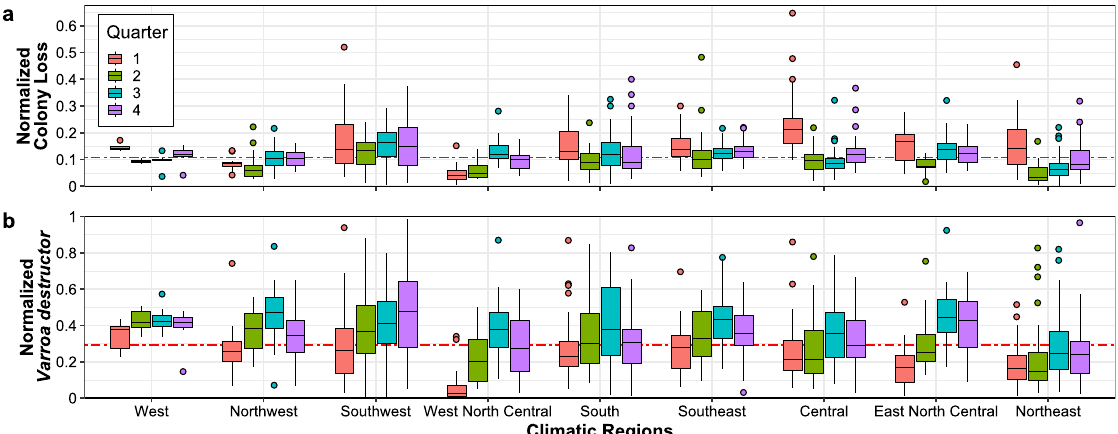
Figure 2. Empirical distribution of honey bee ( Apis mellifera ) colony loss ( a ) and Varroa destructor presence ( b ) across quarters (the first one being January-March) and climatic regions; red dashed lines indicate the overall medians. ( a ) Box plots of normalized colony loss (number of lost colonies over the maximum number of colonies) for each quarter of 2015–2021 and each climatic region. At the contiguous United States level, this follows a stable pattern across the years, with higher and more variable losses during the first quarter (see Supplementary Figs. S2-S6), but some regions do depart from this pattern (e.g., West North Central). ( b ) Box plots of normalized V. destructor presence (number of colonies affected by V. destructor over the maximum number of colonies) for each quarter of 2015–2021 and each climatic region. The maximum number of colonies is defined as the number of colonies at the beginning of a quarter, plus all colonies moved into that region during the same quarter.